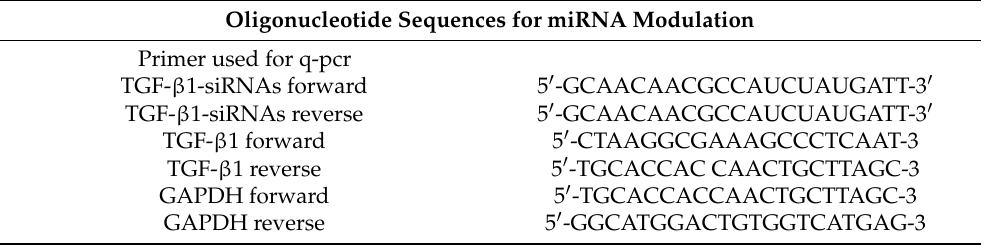
Table 5. Oligonucleotide and primer sets for